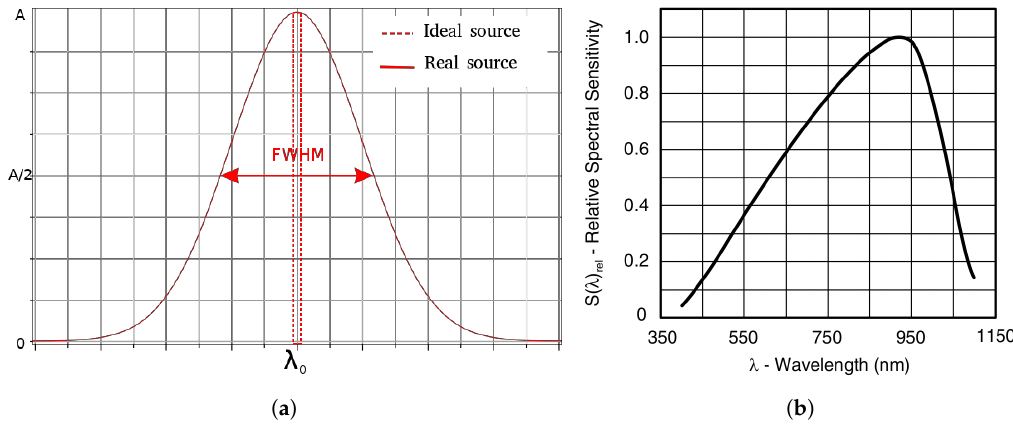
Figure 3. ( a ) Gaussian model typically used for source distribution spectra, compared to the idealistic narrow spectrum ( b ) Relative spectral sensitivity of a typical silicon photodiode